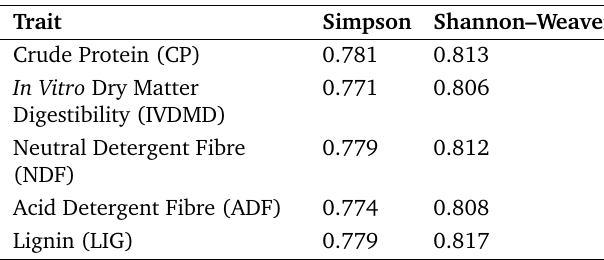
Table 5. Simpson and Shannon–Weaver diversity indices for Stylosanthes scabra Vogel.